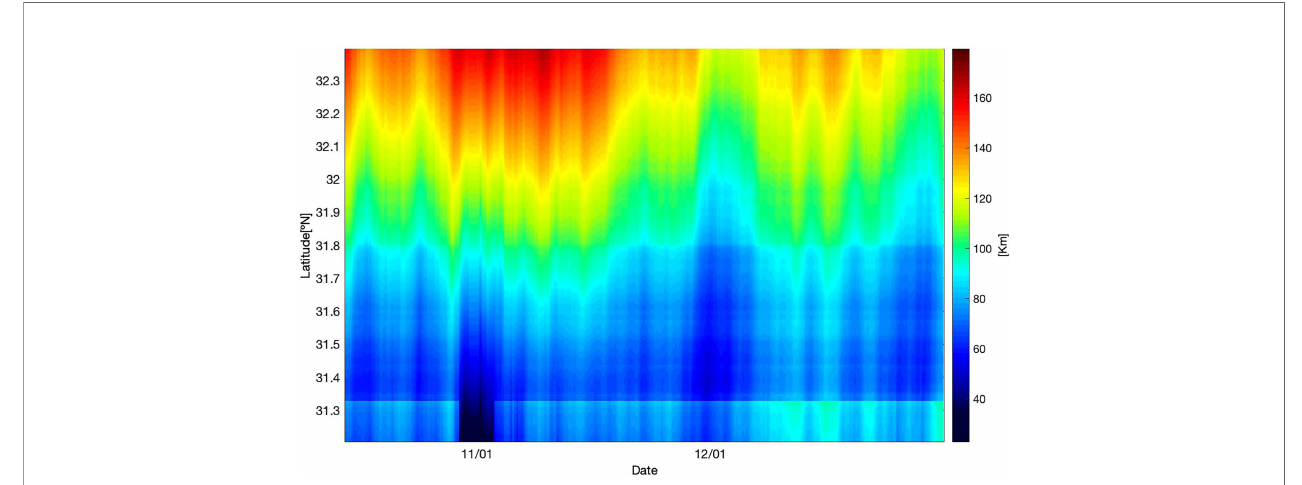
FIGURE 11 | Hovmoeller plot of the minimum distance between the eastern coast of Kyushu and the model Kuroshio axis, de fi ned as the contour of SSH = 0.2 m, as a function of latitude and time.